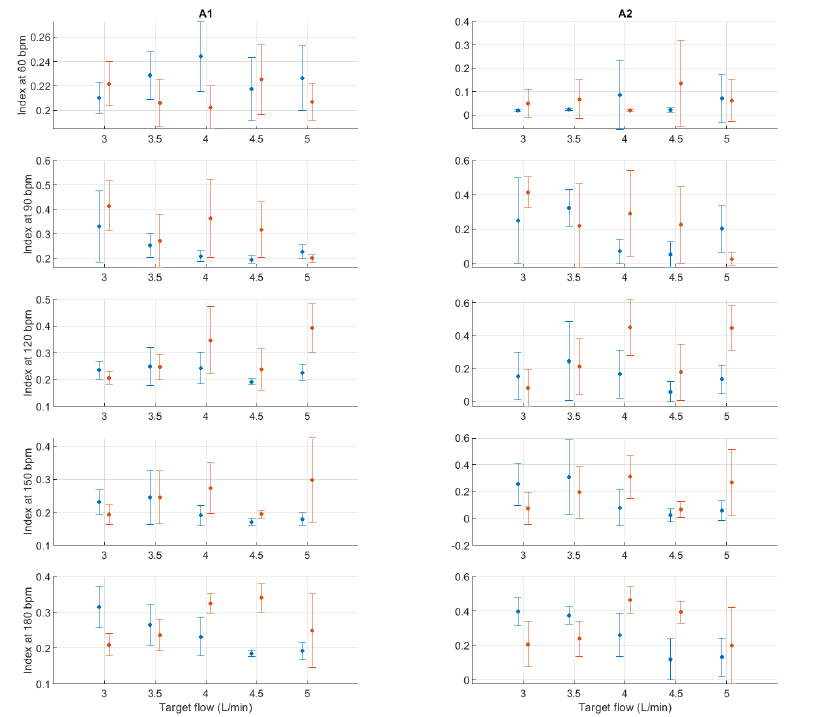
Figure A17. Mean and standard deviation of detrended fluctuation analysis indices extracted from pulse rate variability under different stroke rates (SR) and target flows (TF, TF above 2.5 L/min) conditions, and measured from the radial (blue) and deep palmar arch (orange) phantoms.